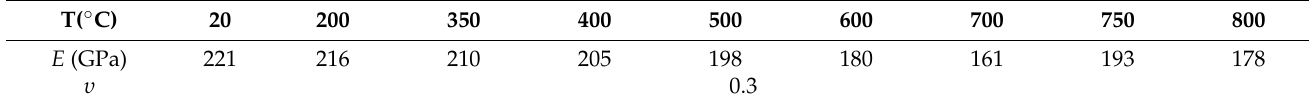
Table 5. Material parameters for